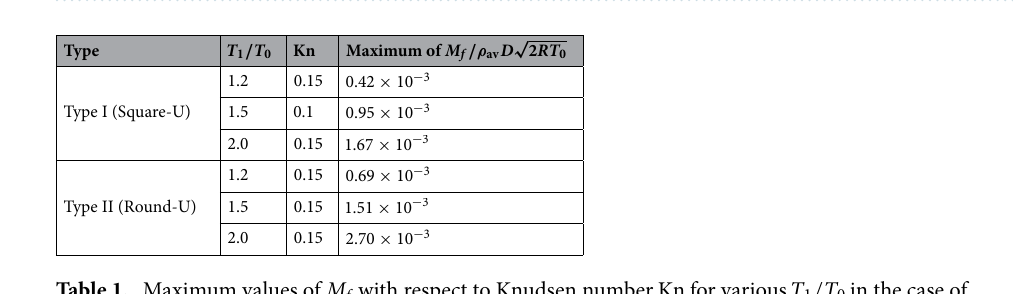
Table 1. Maximum values of M f with respect to Knudsen number Kn for various T 1 / T 0 in the case of H / D 2 and L / D 1 = =